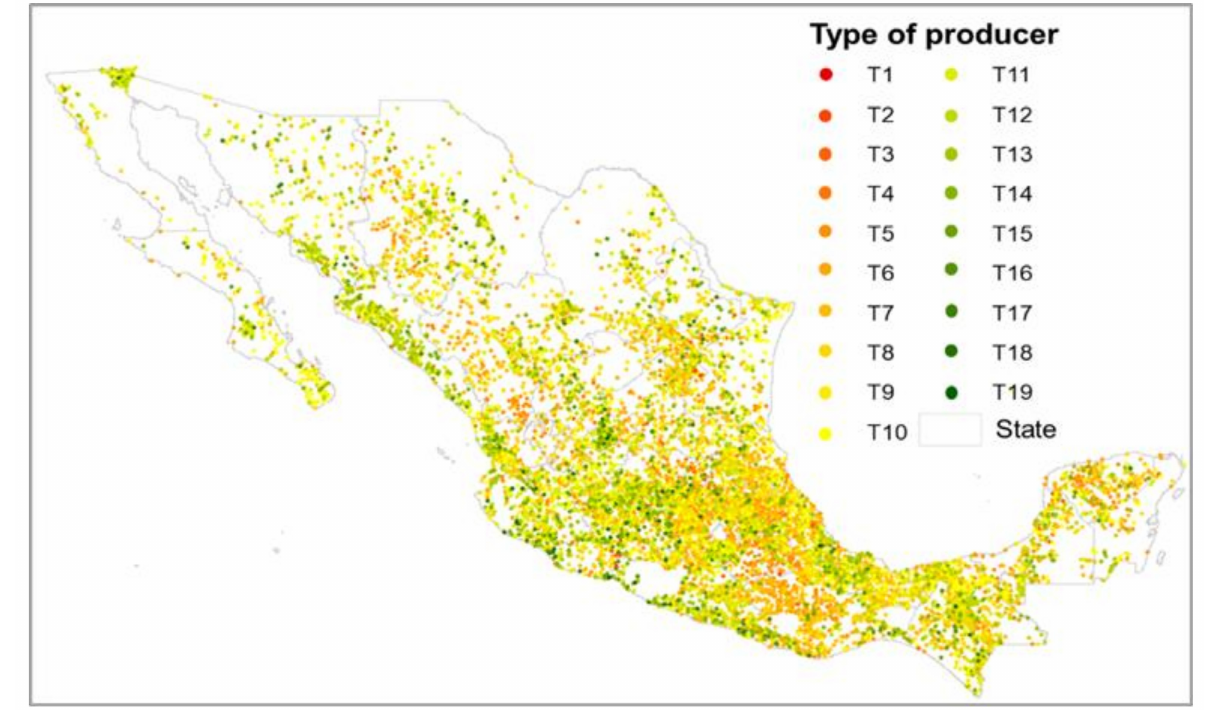
Figure 3. Geographic distribution of the main producer types